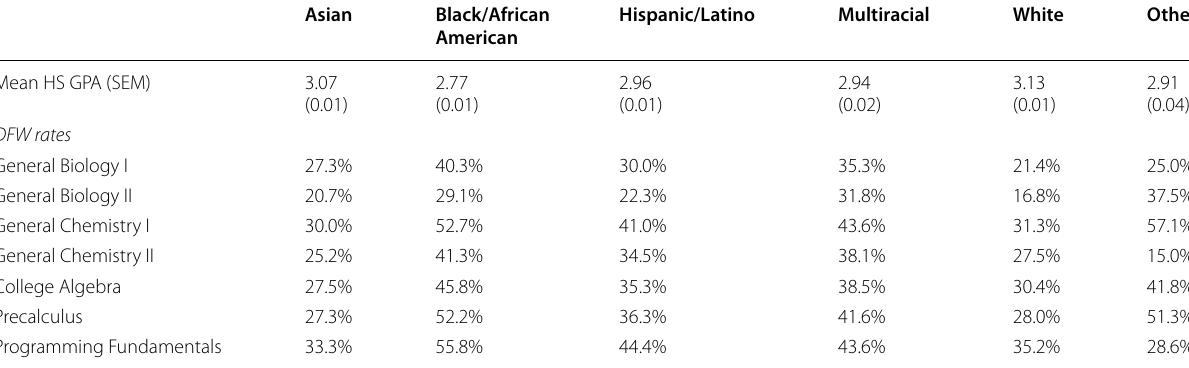
For HS GPAs, numbers in parentheses indicate standard errors of the means